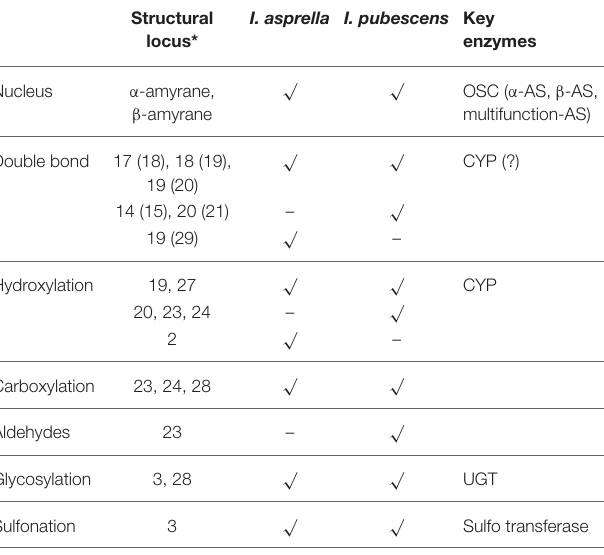
TABLE 3 | Expected key enzymes of triterpenoid biosynthesis in I. pubescens and I. asprella. Structural